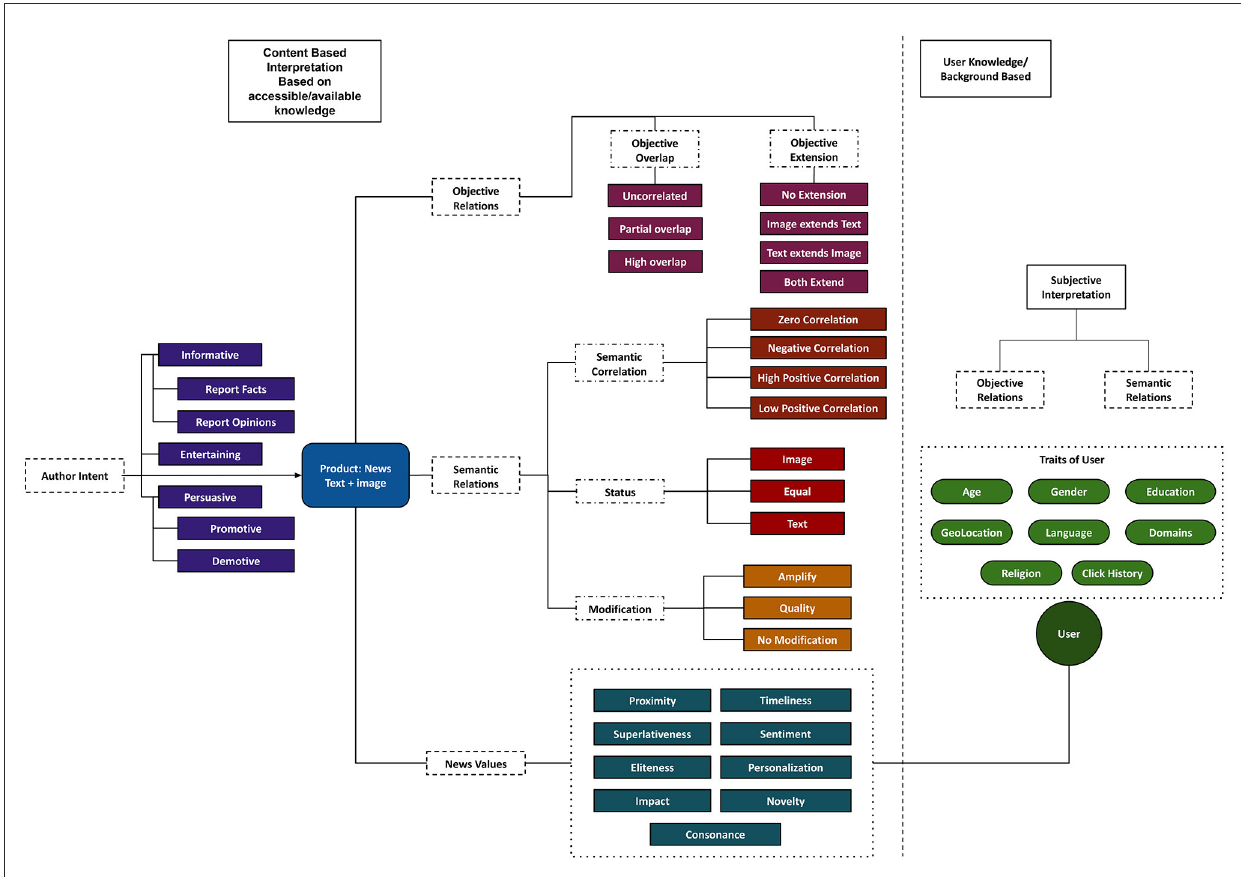
FIGURE2 Proposed framework with different perspectives and classes for multimodal news article